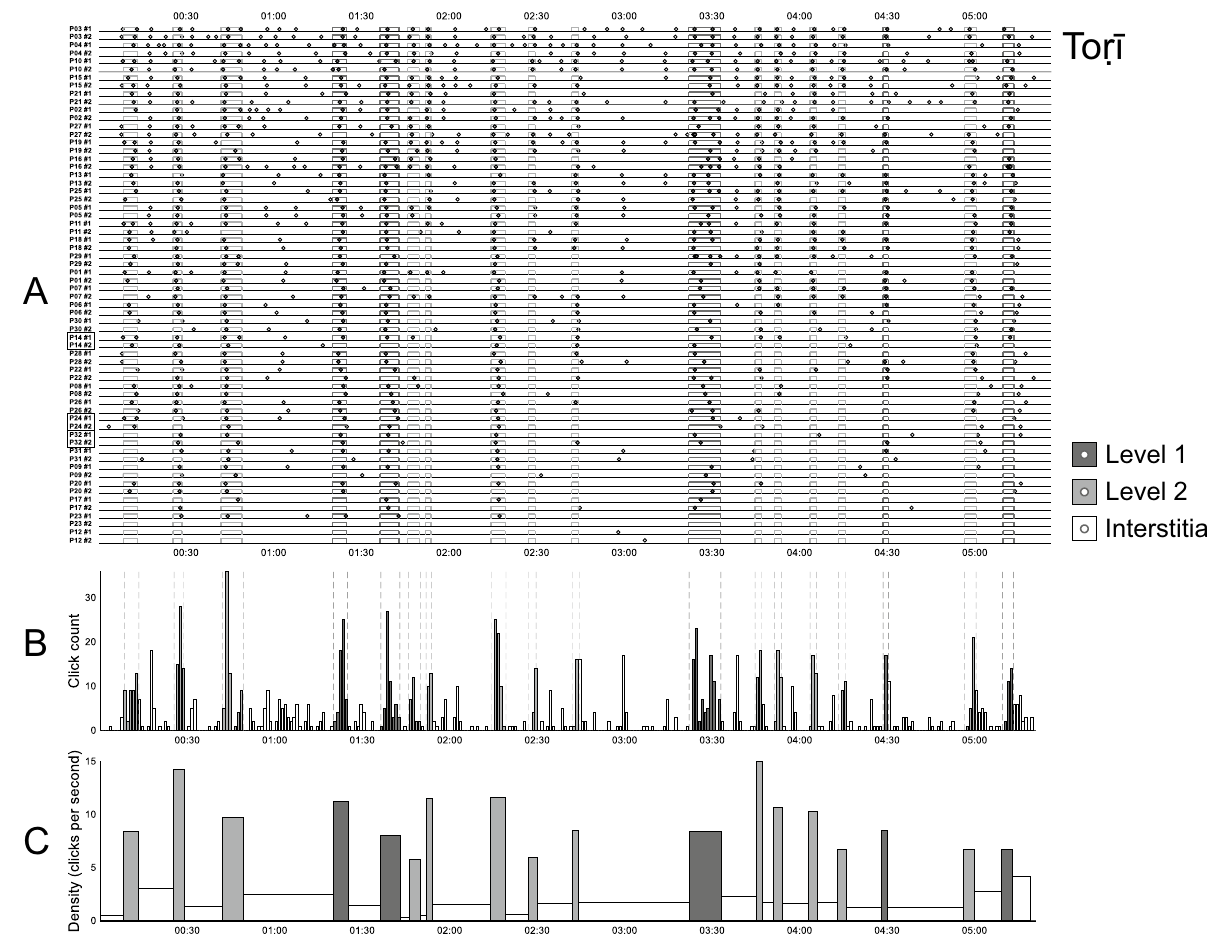
Figure 1. Participant-inserted clicks in relation to EDBRs. For each rāga, top-panel plots ( A ) depict, on each line, the occurrence of clicks (dots) and EDBRs (rectangles) along the timespan of each of a participant’s ("P") two listenings ("#1" and "#2"). Participants are listed in decreasing order of their total number of clicks across repetitions. Middle-panel plots ( B ): histograms counting clicks across all participants and across both listenings, within 1 s bins; vertical dotted lines delimit EDBRs. Bottom-panel plots ( C ): click density histograms at region level; counts are summed for each region and normalised (divided) by the region’s duration. Level 1 boundaries are represented in dark grey, Level 2 in light grey; circles or bars thus filled represent hits (within-boundary clicks), while hollow (white) regions represent false alarms (interstitial clicks). Participants familiar with Indian music are highlighted in black boxes. For animated versions of these plots, with a cursor moving in time with the music, please see the video files uploaded to OSF. https ://osf.io/khvmf